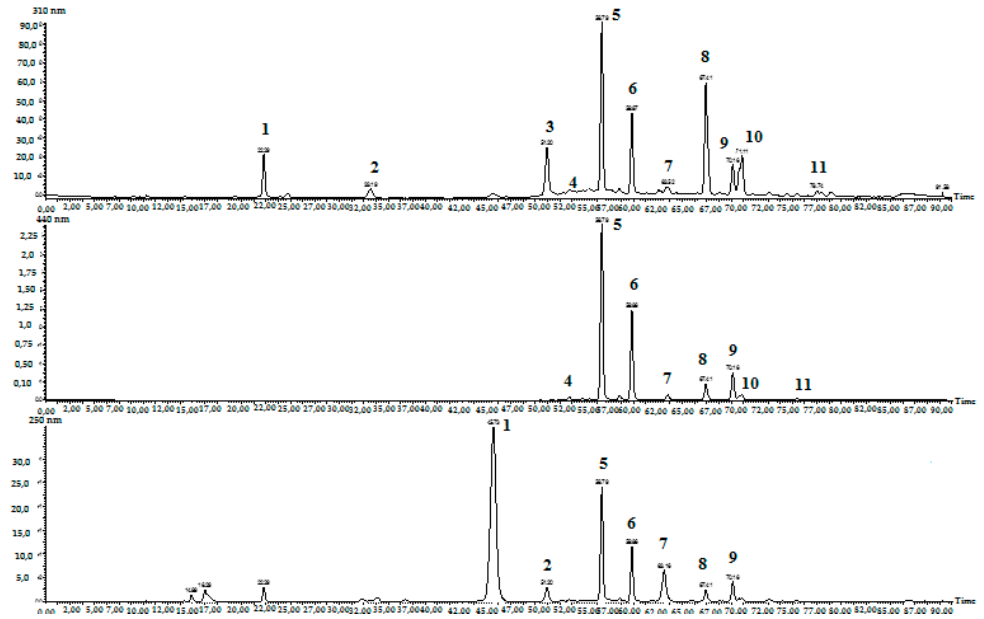
Figure 6. The typical HPLC chromatograms of methanol extract (50%) of saffron stigma recorded at 310 nm, 440 nm, 250 nm. The peak of compounds affiliation according to Tarantilis et al. (1995): 1 — picrocrocin; 2 —picrocrocin acid form; 3 —kaempferol diglycoside; 4 — trans -crocin-5; 5 — trans - crocin-4; 6 — trans -crocin-3; 7 — cis -crocin-5; 8 — cis -crocin-4; 9 — trans -crocin-2; 10 — cis -crocin-3; 11 — cis -crocin-2.